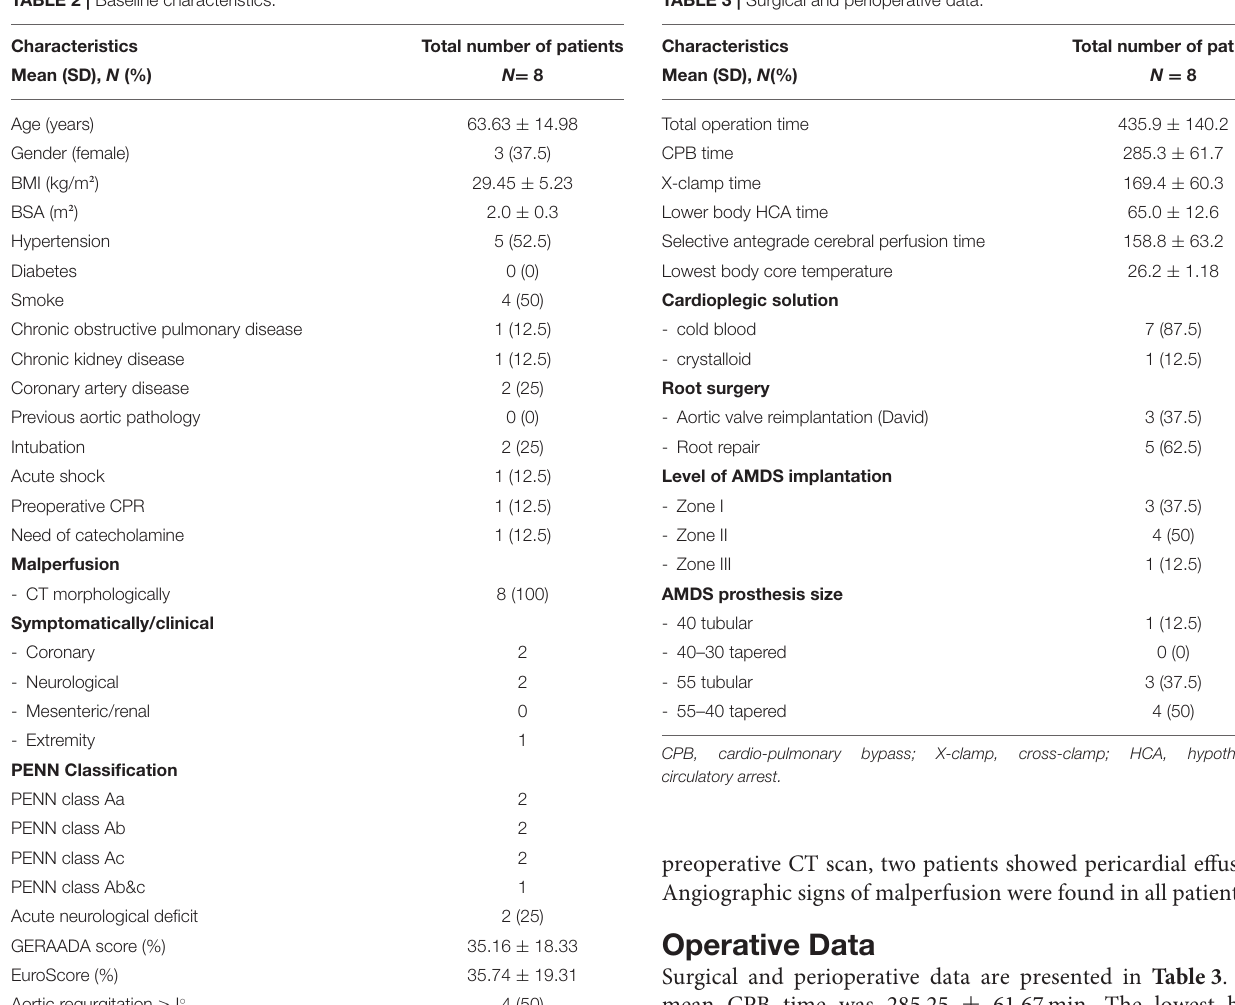
TABLE 2 | Baseline characteristics. TABLE 3 | Surgical and perioperative